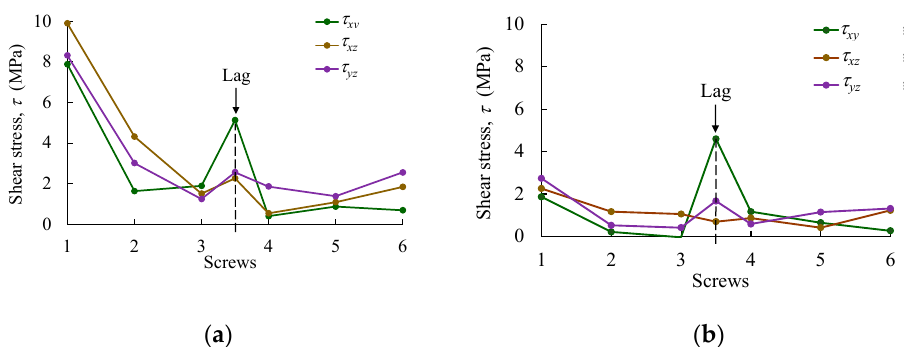
Figure 17. Shear stress in bone regions S1–S6 (and Lag) sited ( a ) in contact with the metal plate and ( b ) on the opposite side of the bone shaft.